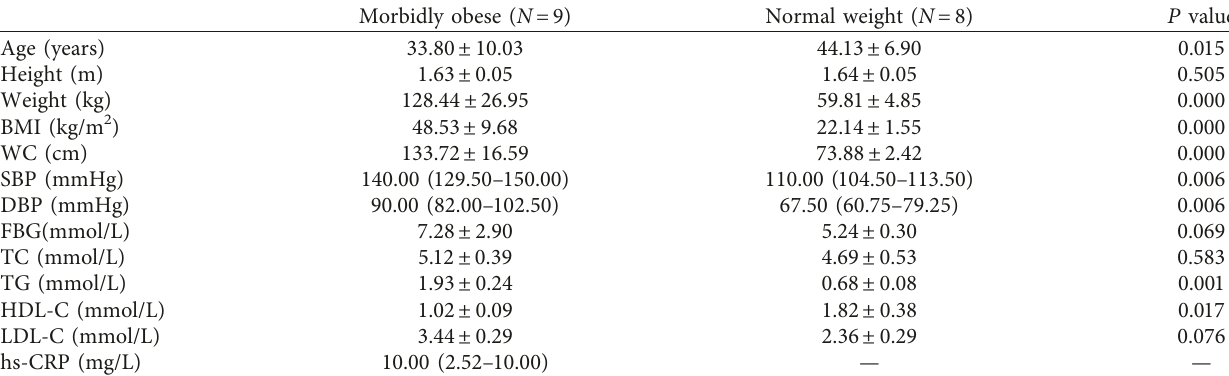
Table 1: Anthropometric and laboratory measurements of morbidly obese and normal weight subjects.